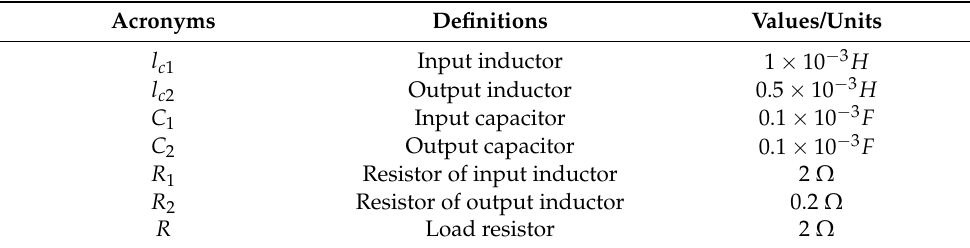
Figure 6. Single-ended primary inductor converter. Table 1. Converter